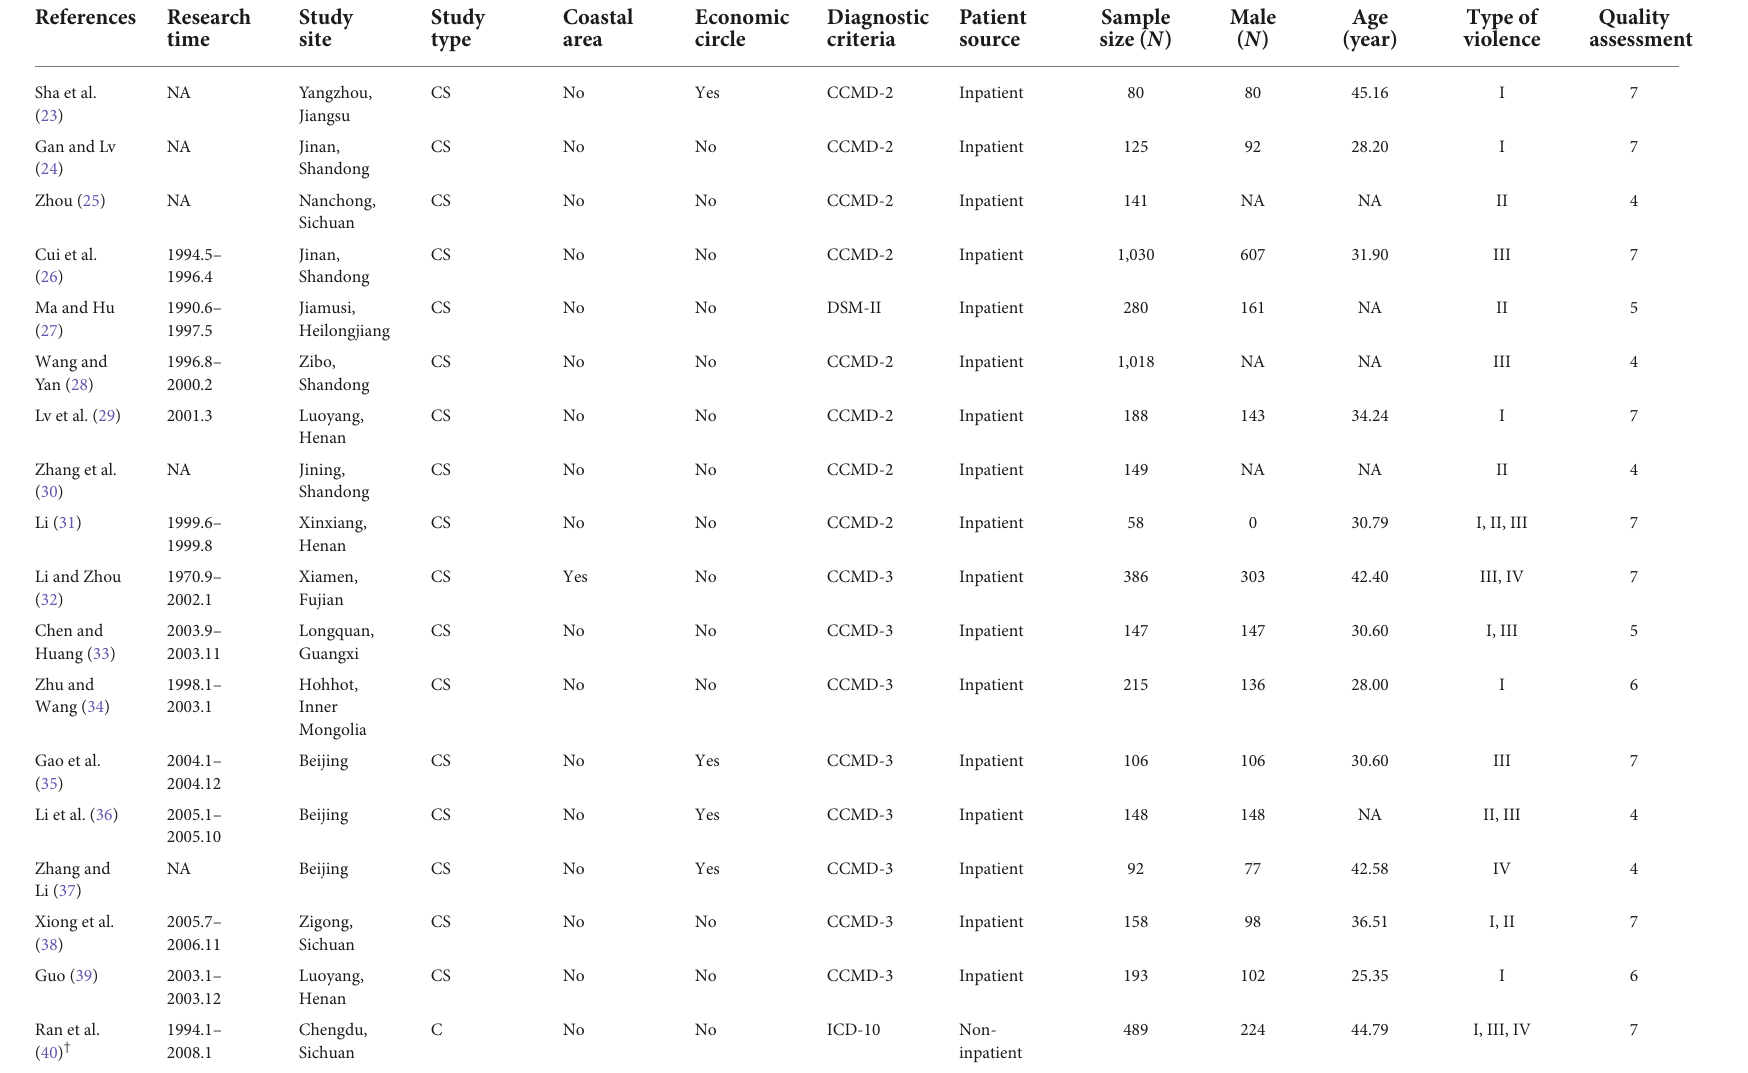
TABLE 1 Characteristics of studies included in the